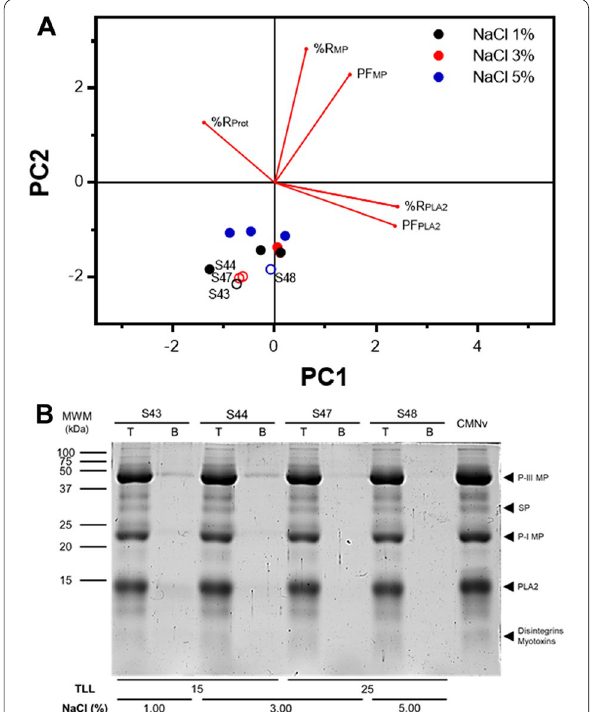
Fig. 2 NaCl concentration effect on the recovery of MPs and PLA 2 in PEG–potassium phosphate systems. A Principal component analysis (PCA) analysis of the recovery metalloproteases (MPs) and phospholipases A2 (PLA 2 ) in selected systems at different NaCl concentrations (1, 3 and 5% w/w). Clear circles ( ○ ) denote the selected ATPS with the best partition characteristics. B SDS‑PAGE of top and bottom phases (T and B, respectively) of selected ATPS from PCA analysis, 15 μg of C. m. nigrescens venom (CMNv) and molecular weight marker